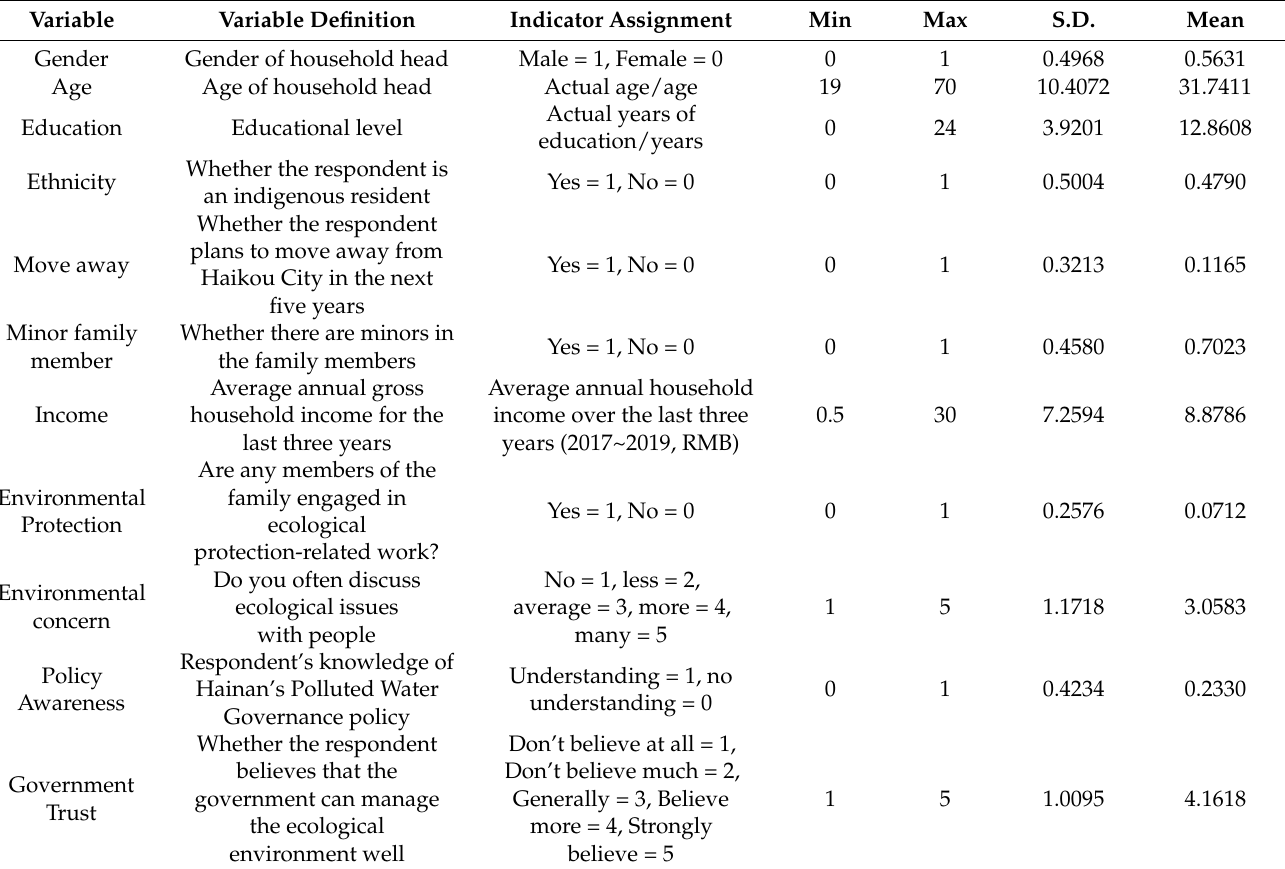
Table 2. Sample description statistics.